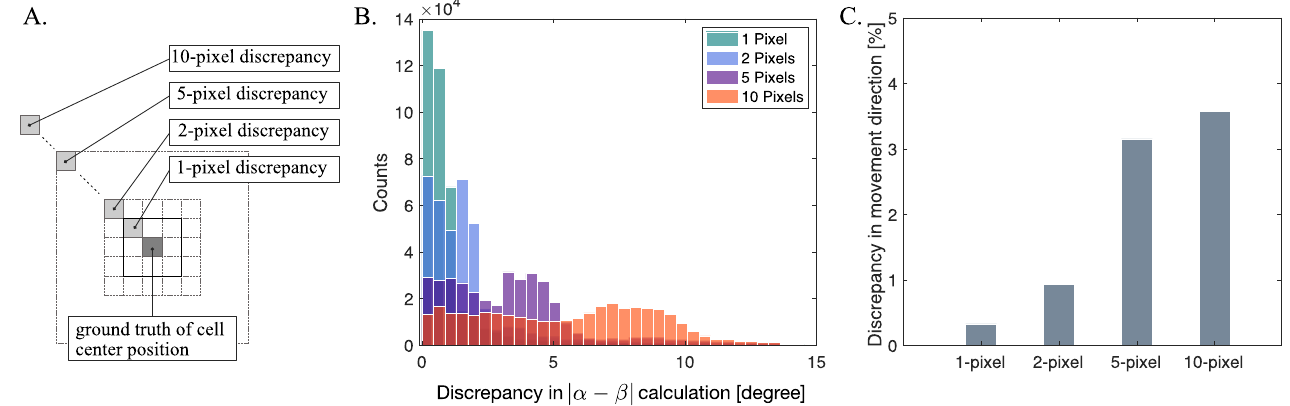
Figure 6. Influence of cell center estimation error in applying the suggested method. ( A ) Concept of discrepancy in cell center estimation for 1, 2, 5, and 10 pixels. ( B ) Representative result of computing the error sizes of | α − β | for a single cell experiment. ( C ) Discrepancy in movement direction represented in percentage compared to the ground truth, according to the discrepancy in cell center estimation in